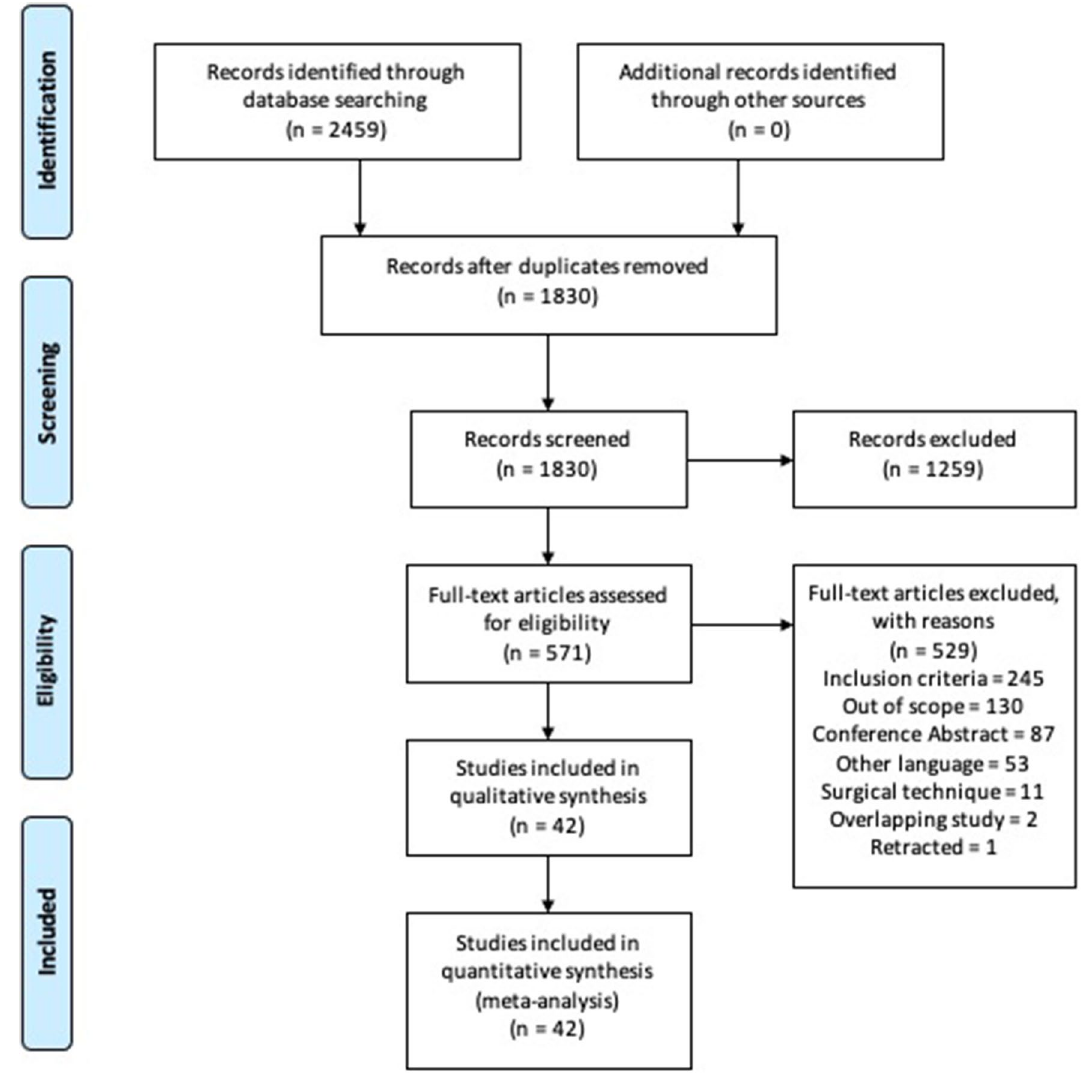
Figure 1. PRISMA flowchart of systematic review and meta-analysis comparing clinical outcomes and complications in endoscopic assisted intraforaminal lumbar interbody fusion (iLIF) versus minimally invasive transforaminal lumbar interbody fusion